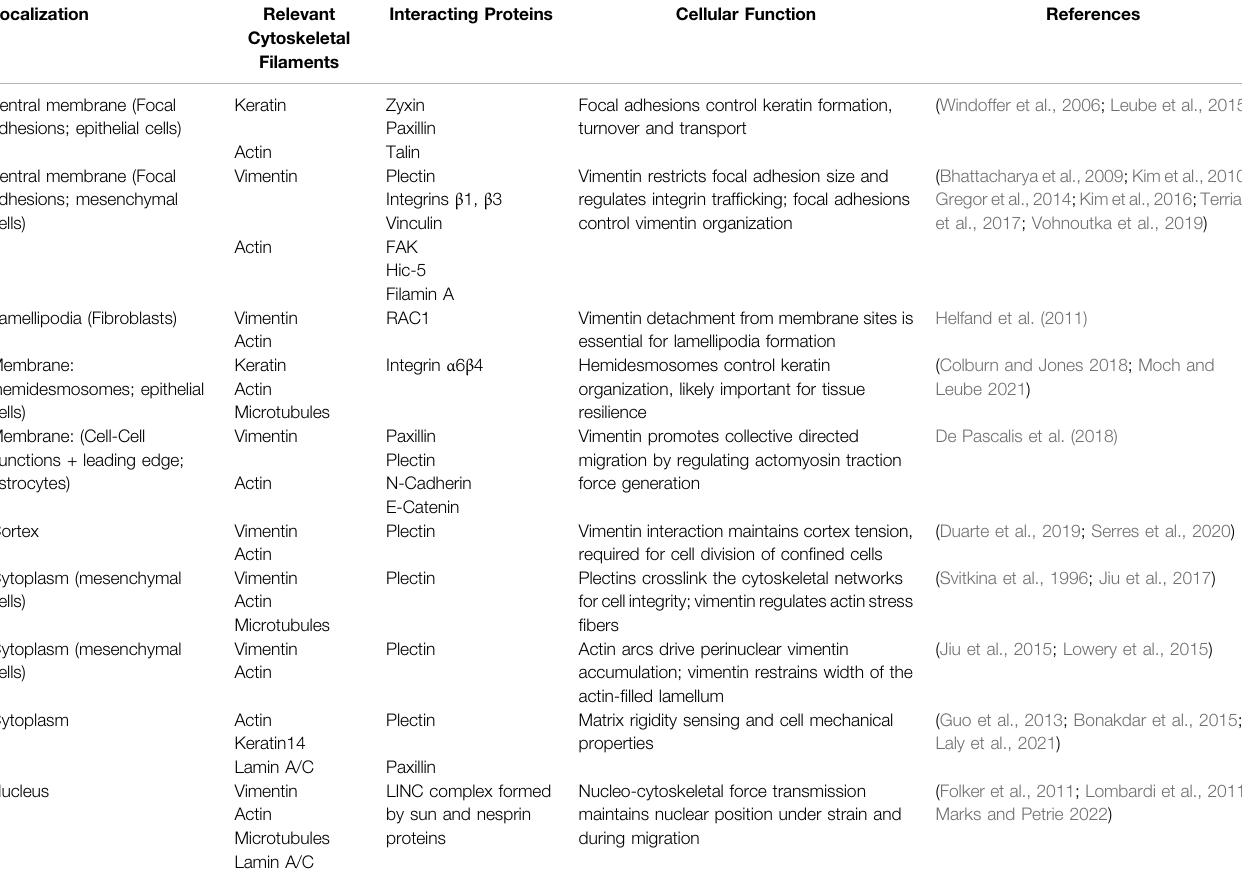
TABLE 1 | Selected examples of known cytoskeletal crosstalk interactions relevant for environmental mechanosensing that involve intermediate fi laments. Interactions are sorted by subcellular localization, noting the structural and crosslinker proteins known to be involved in the crosstalk, as well as the major cellular function. Localization